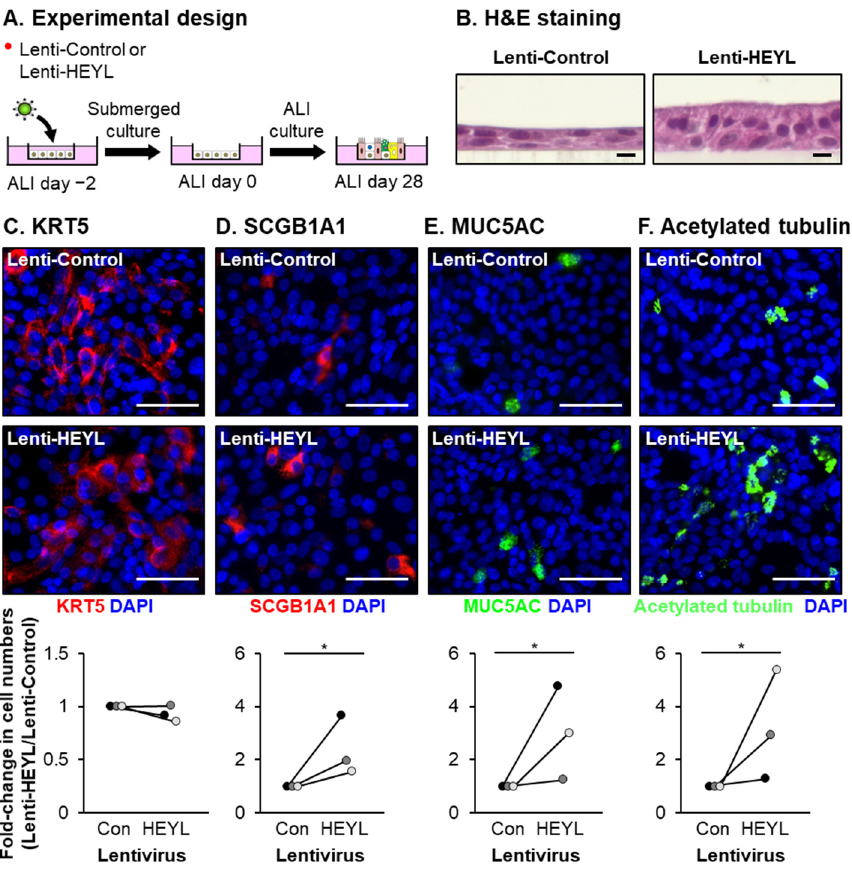
Figure 8. HEYL overexpression can restore differentiation capacity to COPD HBECs in vitro. COPD HBECs ( n = 3 donors) were infected either control lentivirus (Lenti-Control) or lentivirus expressing HEYL (Lenti-HEYL) and then cultured on ALI for 28 days to differentiate into a mucociliary epithelium containing basal, club, goblet and ciliated cells. ( A ) Experimental design. ( B ) Hematoxylin and eosin (H&E) staining. Scale bar = 10 µm. ( C – F ) Immunofluorescent staining and quantification of basal (KRT5, red), club (SCGB1A1, red), goblet (MUC5AC, green) and ciliated cells (acetylated tubulin, green). Nuclei are stained blue with DAPI. For each donor, the data are presented as fold-change in cell numbers compared to Lenti-Control infected cells. Scale bar = 50 µm. * p < 0.05.